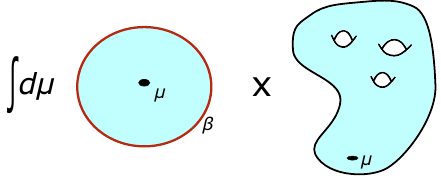
Figure 16 . A graphical representation of formula